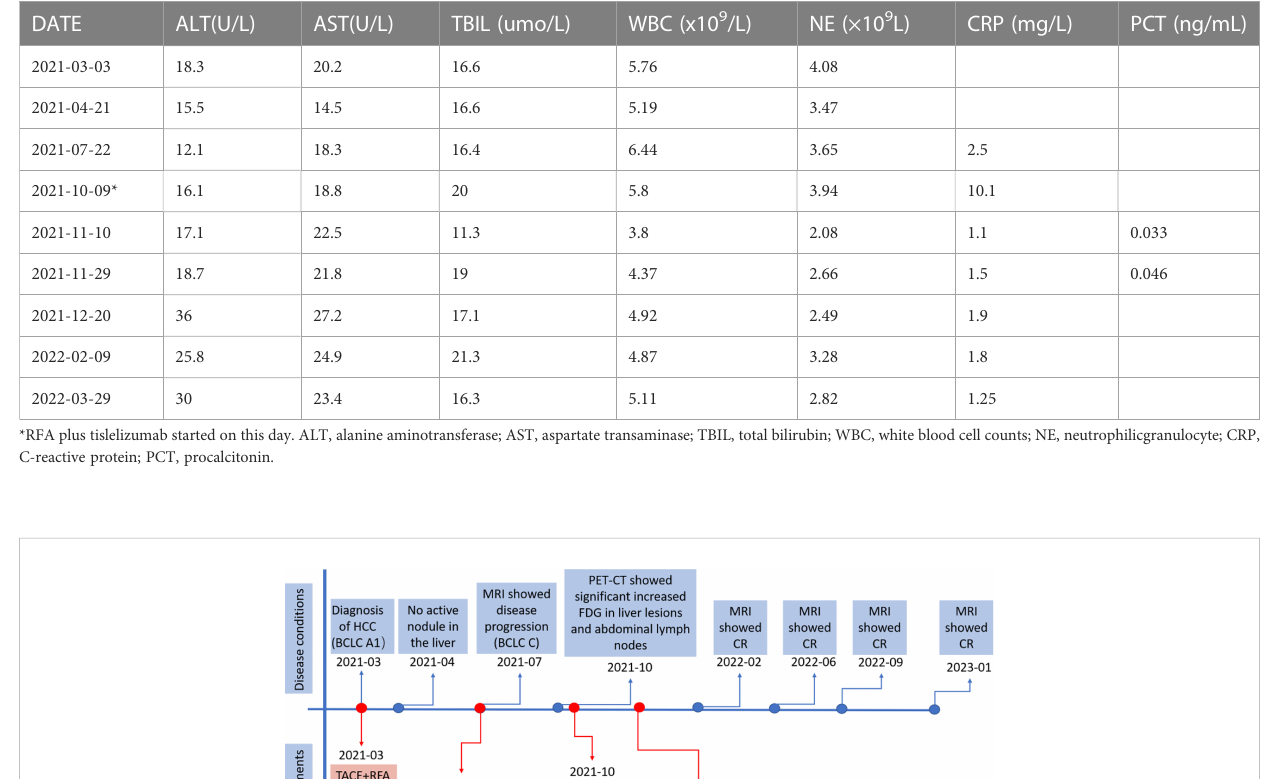
TABLE 1 Summary of liver function and in fl ammatory factors testing in the patient before and after the treatment of tislelizumab.